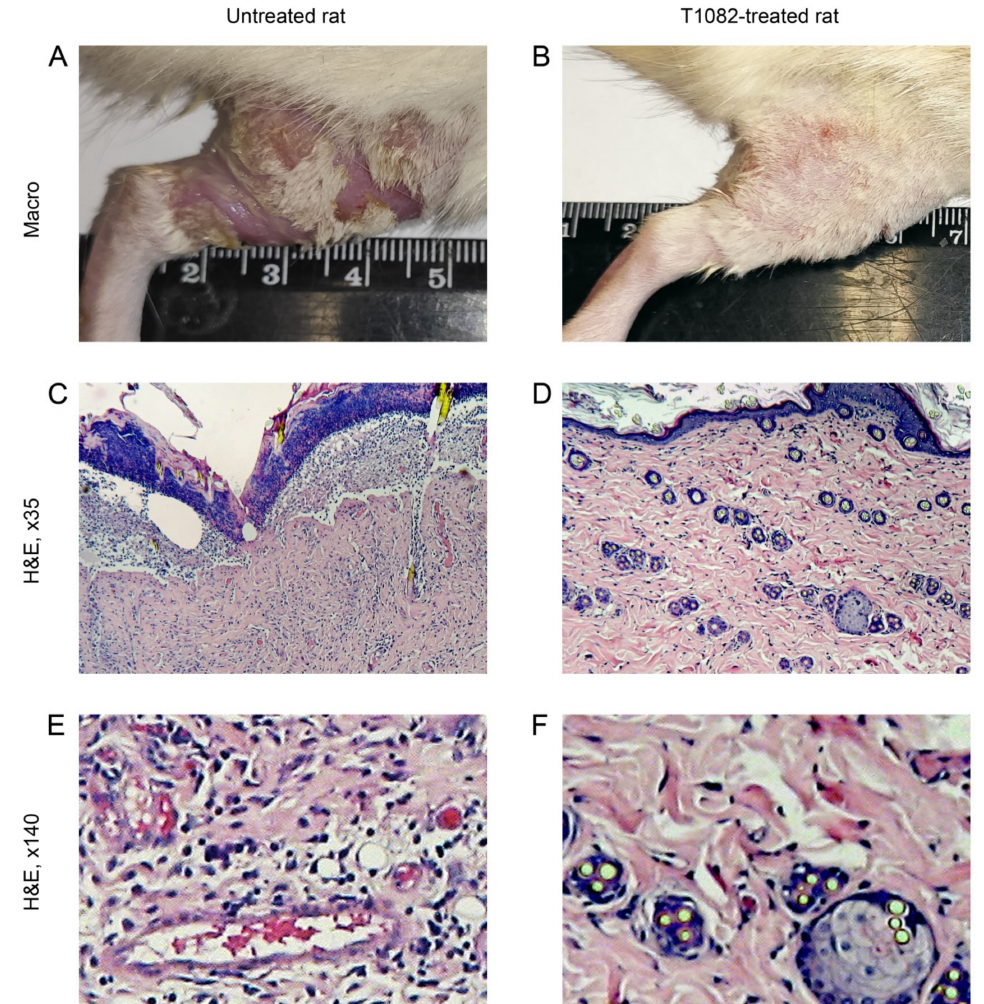
Figure 6. The effect of compound T1082 at a dose of 160 mg/kg (1/14 LD 10 ), i.g., given by multiple administration, on the morphology of rat thigh tissues on the 15th day after the start of fractionated β -ray LI at a total dose of 78 Gy (6 fractions at a dose of 13 Gy with 24 h intervals). ( A , B ) Macroscopic pictures. ( A ) Untreated rat. The RSR corresponds to 4 degrees according to the RTOG scale: severe hyperemia and edema, confluent exudative epidermitis spread over the entire surface of the thigh, and a radiation ulcer (3 × 4 × 3 mm) on the knee joint with purulent contents. ( B ) T1082-treated rat. The RSR corresponds to 2 degrees according to the RTOG scale: epilation, hyperemia, and dry epidermitis, which, in some places, took on an islet wet form. ( C , D ) General histological picture of thigh tissues (H&E; × 35). ( C ) Untreated rat. The epidermis is missing and the papillary layer is intensively infiltrated with leukocytes and exfoliates, forming cavities filled with necrotic masses and leukocytes; destroyed follicles and sebaceous glands are observed in the reticular layer and the hypodermis is sharply expanded due to severe edema and loosening of the fibers. Vessels in adipose tissue are dilated and altered. Edema is present on the internal basement membrane, perimysium, and endomysium of the muscles. ( D ) T1082-treated rat. The epidermis is preserved, although it is unevenly thickened due to basal and spiny cell proliferation; in the moderately edematous dermis, intact appendages with a thickened outer epithelium are visible and, in the hypodermis, there is a slight perivascular edema, while muscle fibers are unchanged. ( E , F ) Fragments of C-D, respectively (H&E, × 140). ( E ) Untreated rat. Edema, loosening of collagen fibers, and leukocyte infiltration in the hypodermis; subcutaneous vessels are dilated, and, in some places, there is detachment of the endothelium and atresia of the lumen of the vessels by aggregated erythrocytes. ( F ) T1082-treated rat. Hypertrophy of the outer epithelial layer of hair follicles and sebaceous